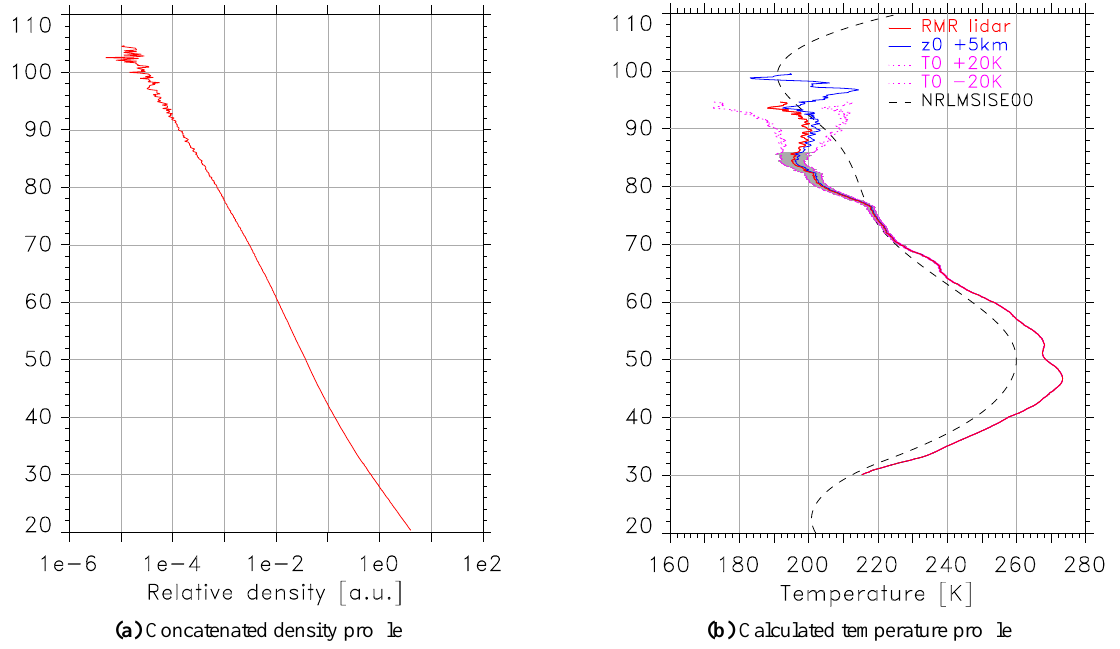
Fig. A3. Example for the downward temperature integration as described in Sect. 3 for the measurement on 13 February 2005 17:00UT– 05:00UT. Left panel: Concatenated relative density profiles (note the exponential scale on the x-axis). Right panel: Corresponding temper- ature profile in red with the start temperature taken from NRLMSISE00 (black dashed line). The violet lines show the resulting temperature profiles when the start temperature is varied by ± 20K. For the blue line the temperature integration was started 5km higher. The gray error bars are shown where the statistical error of the red profile drops below